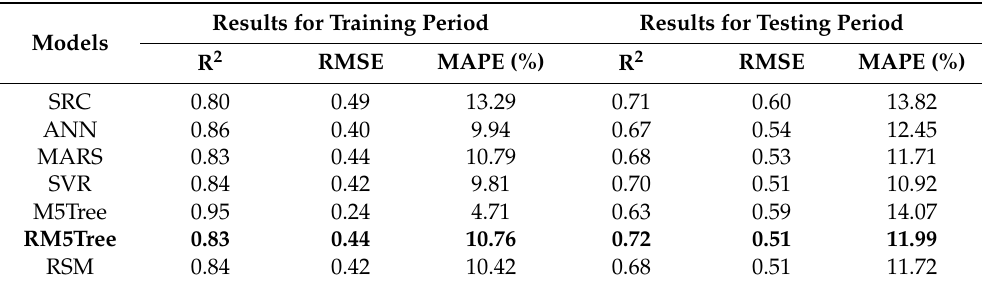
Table 4. Training and testing statistics of the ANN algorithm using various input combinations for the Gilgit River basin. Table 10. Performance accuracy comparison between the SRC, ANN, MARS, SVR, M5Tree, RM5Tree, RSM and SVR model results in the predictions of sediment yields in the Gilgit River